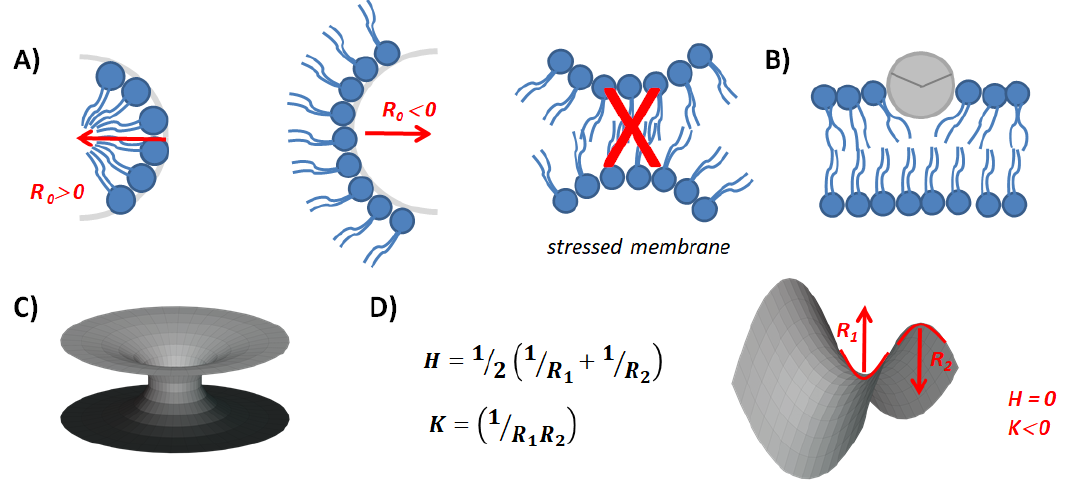
Figure 2. Illustration of curved lipid structures. ( A ) Positive- and negative-curved lipid surfaces. ( A ) membrane composed of negative curvature-forming lipids cannot be accommodated in a planar bilayer structure, which results in curvature stress. See also [22]. ( B ) The adsorption of an α -helix peptide to a membrane hemilayer induces a positive curvature bending and alters its C 0 and K B . The circle represents an axial view of an amphiphilic helix. Extracted from [42]. ( C ) Representation of an hourglass or stalk surface, which constitutes a fusion intermediate structure. ( D ) Saddle point surface with a zero main curvature ( H ) and a negative Gaussian curvature ( K ). The prolongation of this minimal surface results in a stalk. Extracted from [43].